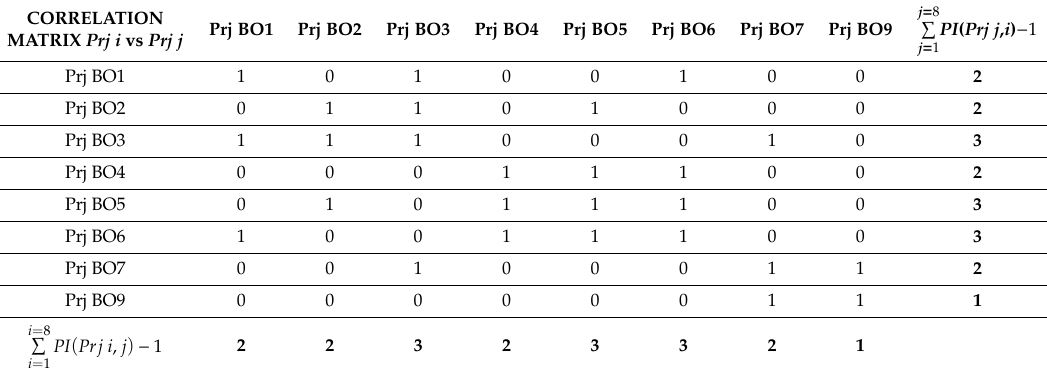
Table 3. Correlation matrix for Bologna project interdependencies (PI)